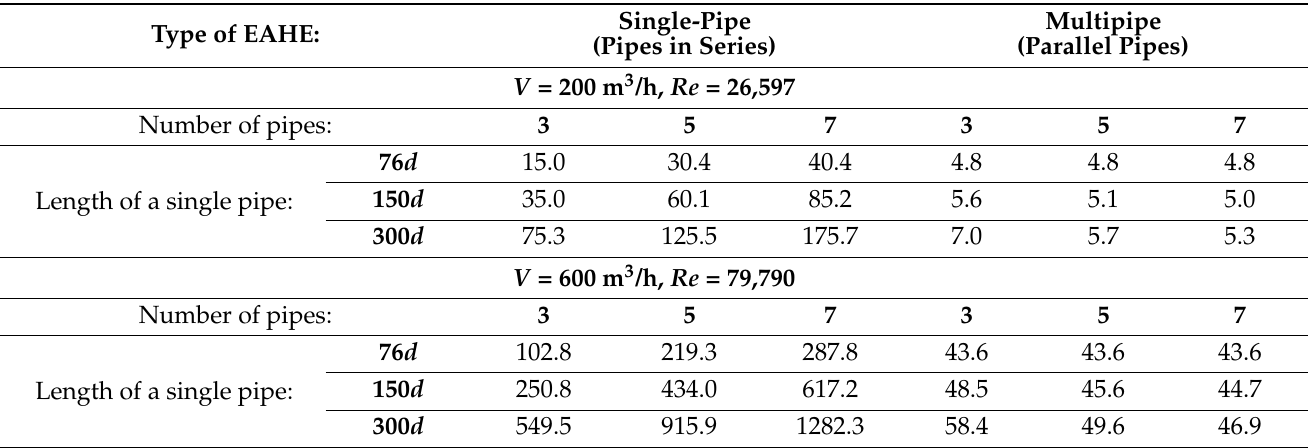
Table 3. Comparison of total pressure losses given in Pa in different structures of single-pipe and multipipe EAHEs. Type of EAHE: